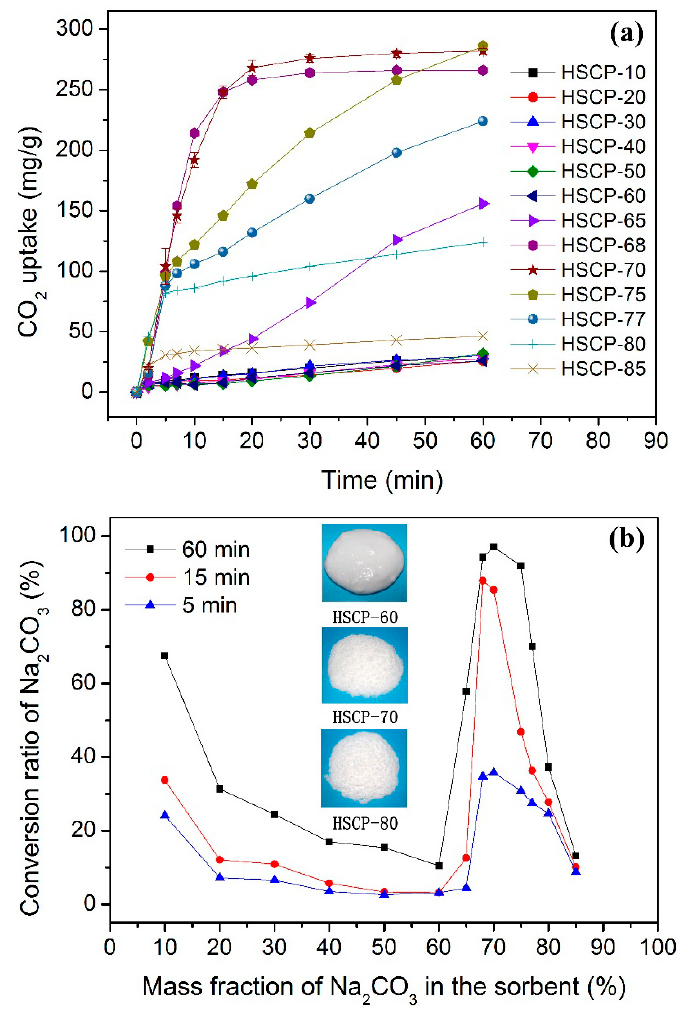
Figure 1. ( a ) CO 2 sorption kinetics of various HSCPs at 30 °C; ( b ) conversion ratio of Na 2 CO 3 in various HSCPs and different reaction time.